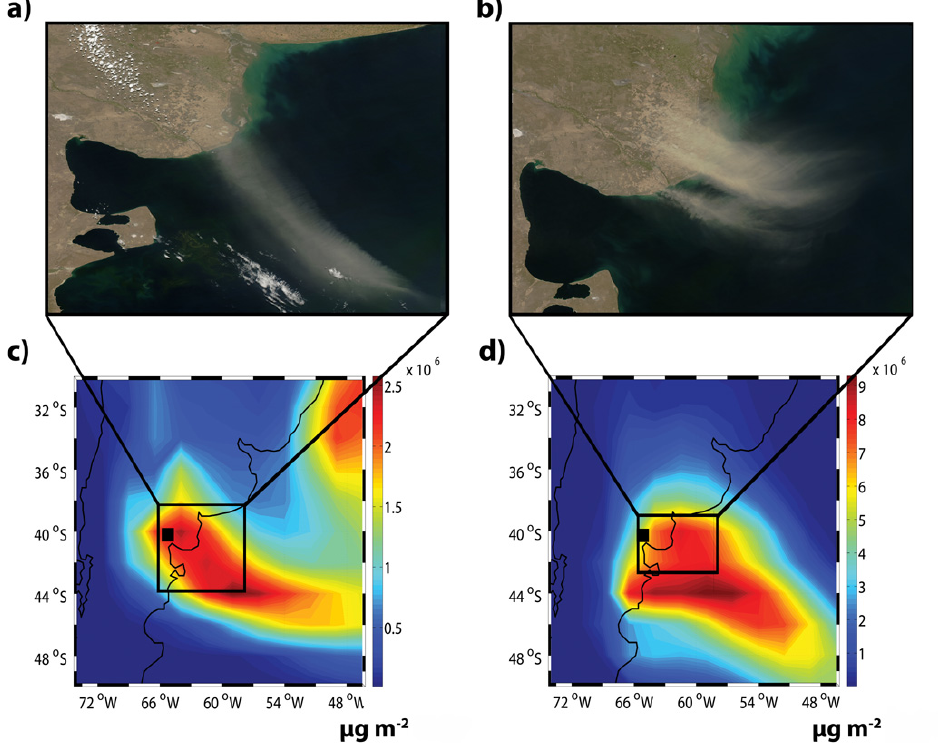
Fig. 1. Aqua MODIS real-time imagery at (a) 18:40UTC 23 January 2009 and (b) 18:35UTC 17 February 2009 and GEOS-Chem-predicted daily-averaged vertically-integrated dust concentration (µgm − 2 ) of Patagonian dust plumes advecting off the coast of South America on (c) 23 January 2009 and (d) 17 February 2009, respectively. The black square indicates the location of San Antonio Oeste (40.8 ◦ S, 65.1 ◦